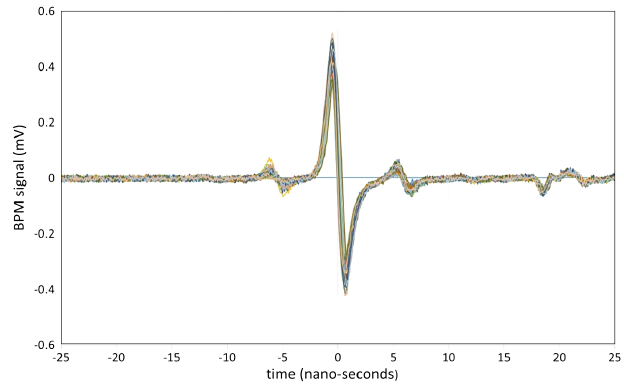
FIG. 9. Superposition of waveforms of signals induced on the beam position Monitor by 50 consecutive fast chopper triggers. Induced signals indicate effective single RFQ bunch selection with less than 15% satellite